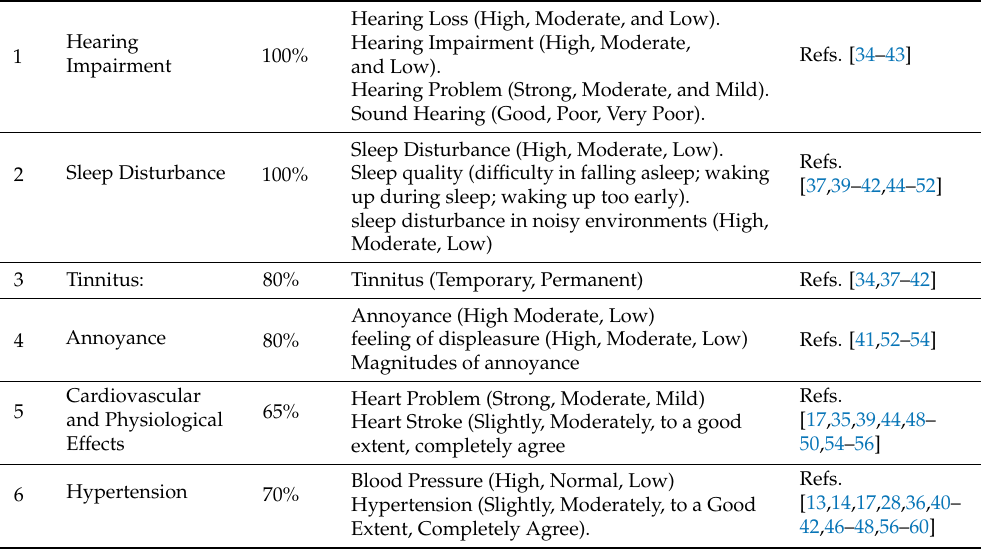
Figure 13. Various health hazards of noise exposure as reported in the literature.